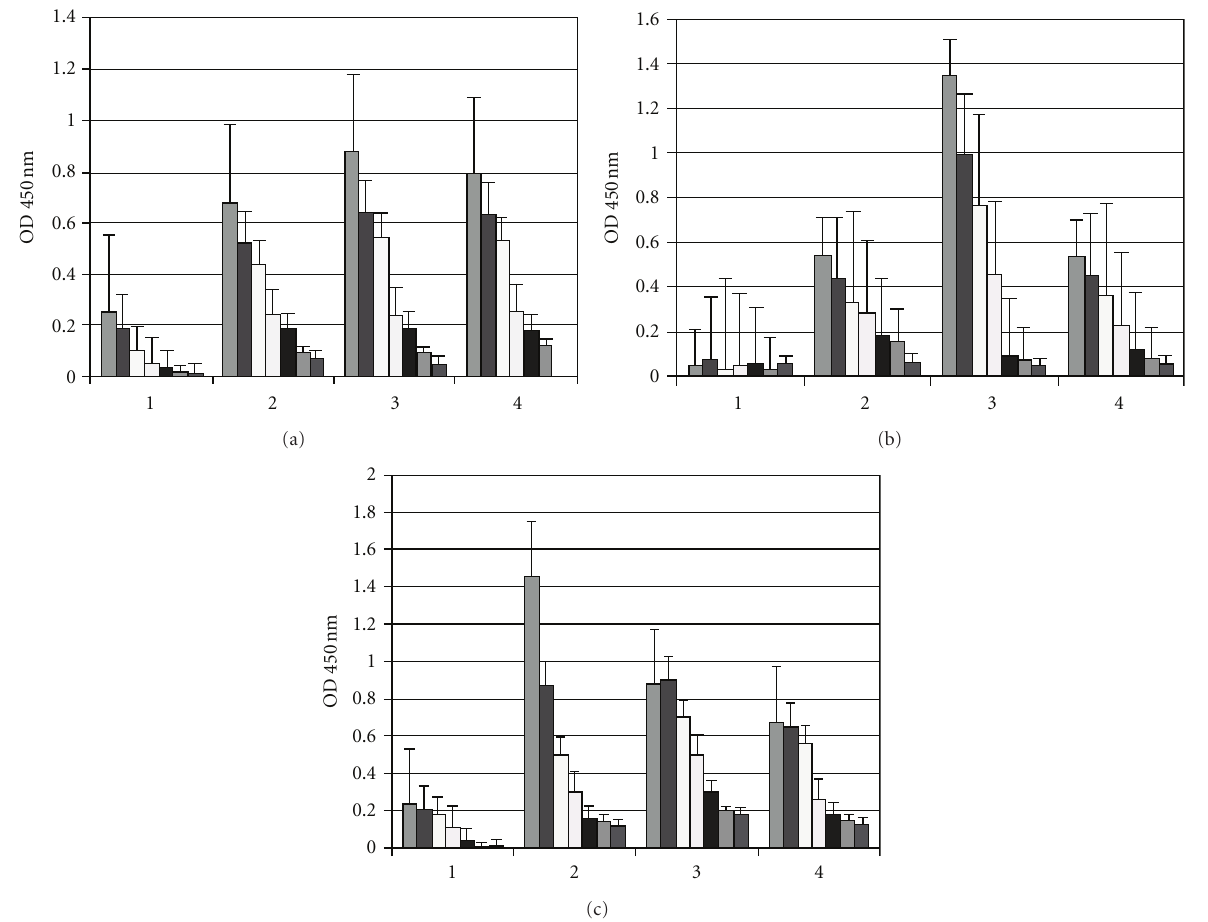
Figure 4: Concentration of specific anti-OMPs IgA in saliva and vaginal washes of adult mice immunized i.n./i.m. at 42 days, 7 days post the i.m. prime-boost. (a) IgA saliva. (1) IgA saliva antibodies in normal mice; (2) IgA saliva antibodies pooled from nine mice immunized with OMPs and Stx1; (3) IgA saliva antibodies pooled from eight mice immunized with OMPs and Stx2; (4) IgA saliva antibodies pooled from ten mice immunized with OMPs and CT (b) IgA of vaginal washes. (1) IgA vaginal washes antibodies in normal mice; (2) IgA vaginal washes antibodies pooled from nine mice immunized with OMPs and Stx1; (3) IgA vaginal washes antibodies pooled from eight mice immunized with OMPs and Stx2; (4) IgA vaginal washes antibodies pooled from ten mice immunized with OMPs and CT. Each scale bar represents the mean ± SE of mice per group in an experiment representative of two separate experiments. (a) OMPs and stx1 IgA containing formulations saliva versus vaginal washes ( P < 0 . 001). (b) OMPs and stx2 IgA containing formulations saliva versus vaginal washes ( P < 0 . 001). (c) OMPs and CT IgA containing formulations salivaversus vaginal washes ( P < 0 .